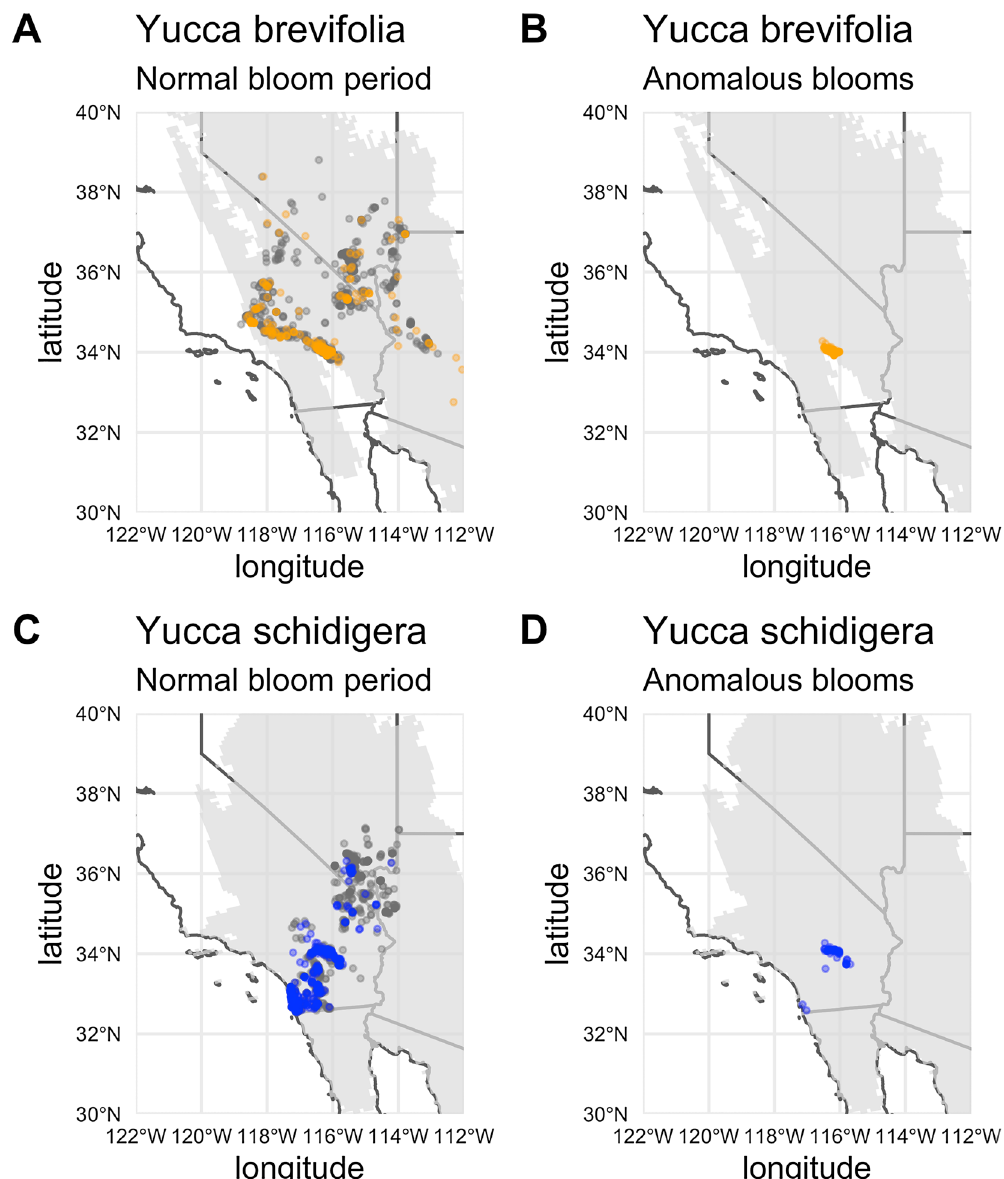
Figure 1. The spatial distribution of occurrence records used in the analyses (2009–2020). The gray polygon in the background of each plot portrays the presumed range for the species. Colored dots indicate flowering presences, and gray-scale dots indicate flowering absences. This figure was generated using R version 4.0.3 23 and the R packages rnaturalearthhires (https:// docs. ropen sci. org/ rnatu ralea rthhi res/), ggplot2 24 , and spData (https:// nowos ad. github. io/